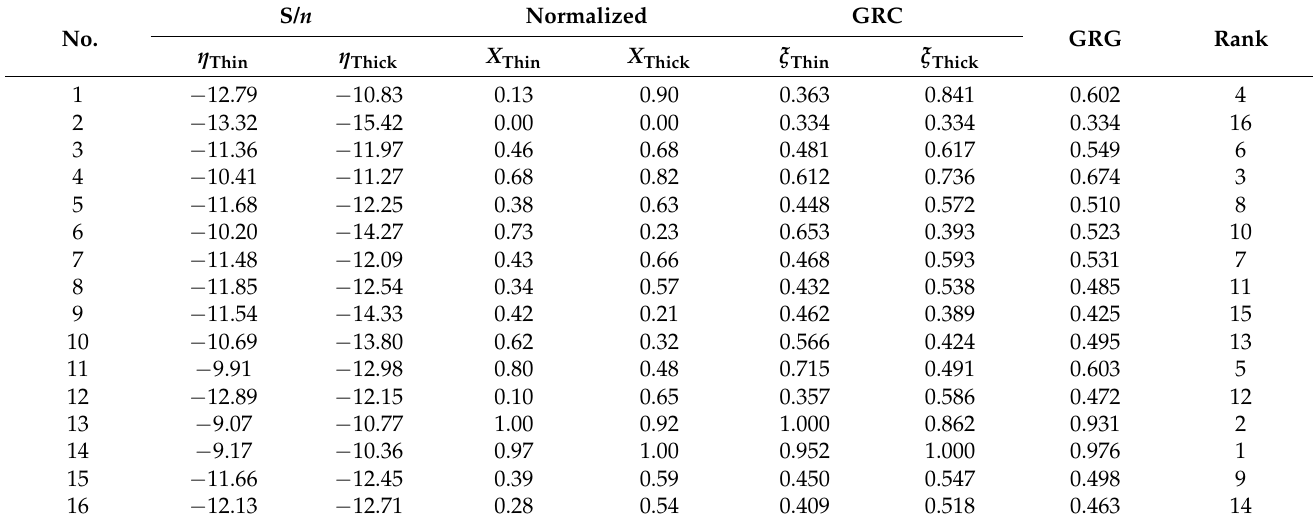
Table 6. Value of Grey Relational Coefficient and Grey Relational Grade.